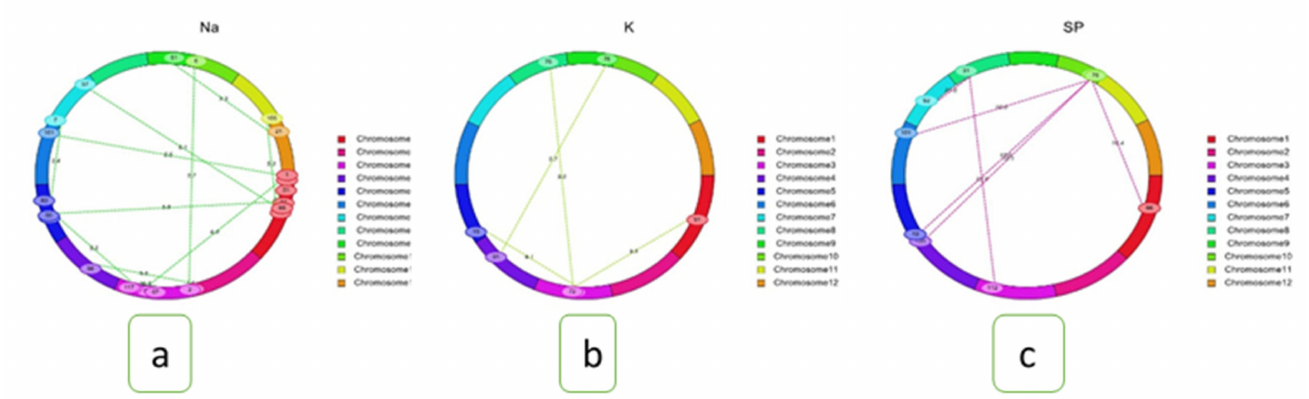
Figure 5. Cyclic diagrams of epistatic interactions of QTLs (E-QTLs) associated with salt tolerance indices: ( a ) Na + concentration, ( b ) K + concentration, and ( c ) survival rate. The 12 colors in the ring indicate the 12 chromosomes of rice. The numbers in the ovals represent the marker positions on chromosomes. The dotted lines indicate the interacting marker pairs located on the same or different chromosomes with corresponding LOD scores due to epistatic effects